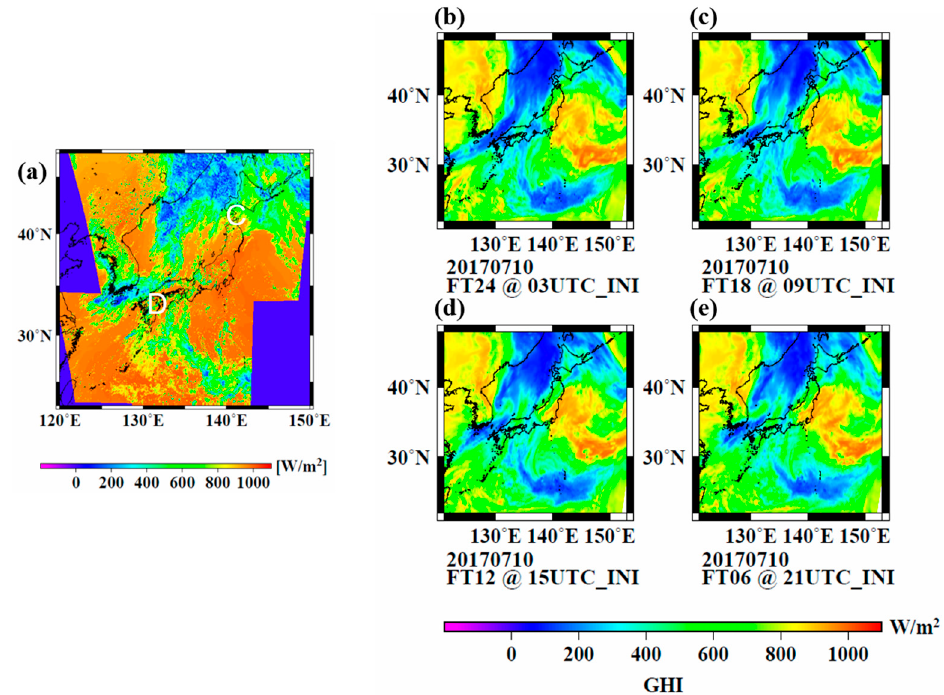
Figure 12. ( a ) Satellite-estimated GHI (AMATERASS data) at 12 JST on 11 July 2017. MSM GHI forecasts of ( b ) 24-h forecasts with initialization time of 03 UTC on 10 July, ( c ) 18-h forecasts with initialization time of 09 UTC, ( d ) 12-h forecasts with initialization time of 15 UTC and ( e ) 6-h forecasts with initialization time of 21 UTC.